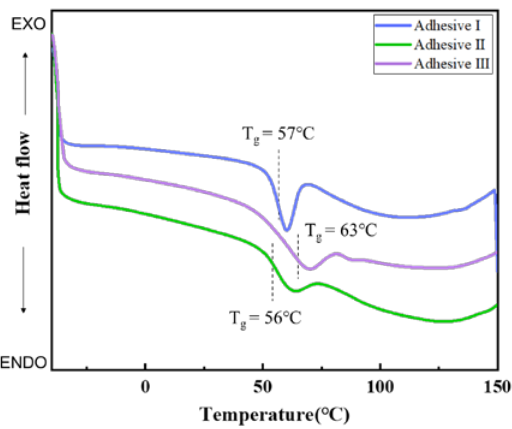
Figure 4. DSC curves of investigated adhesives.